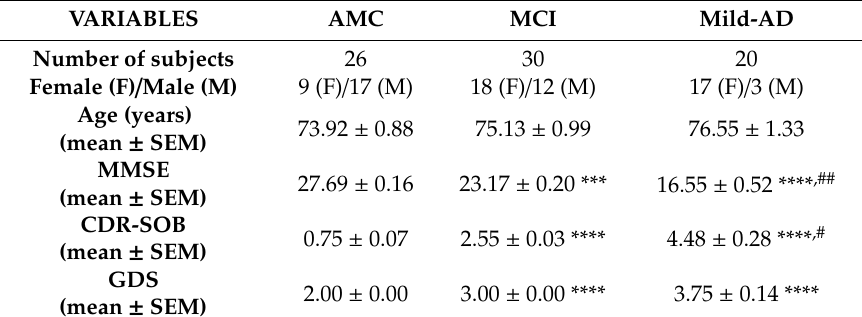
Table 1. Demographic and clinical parameters of studied